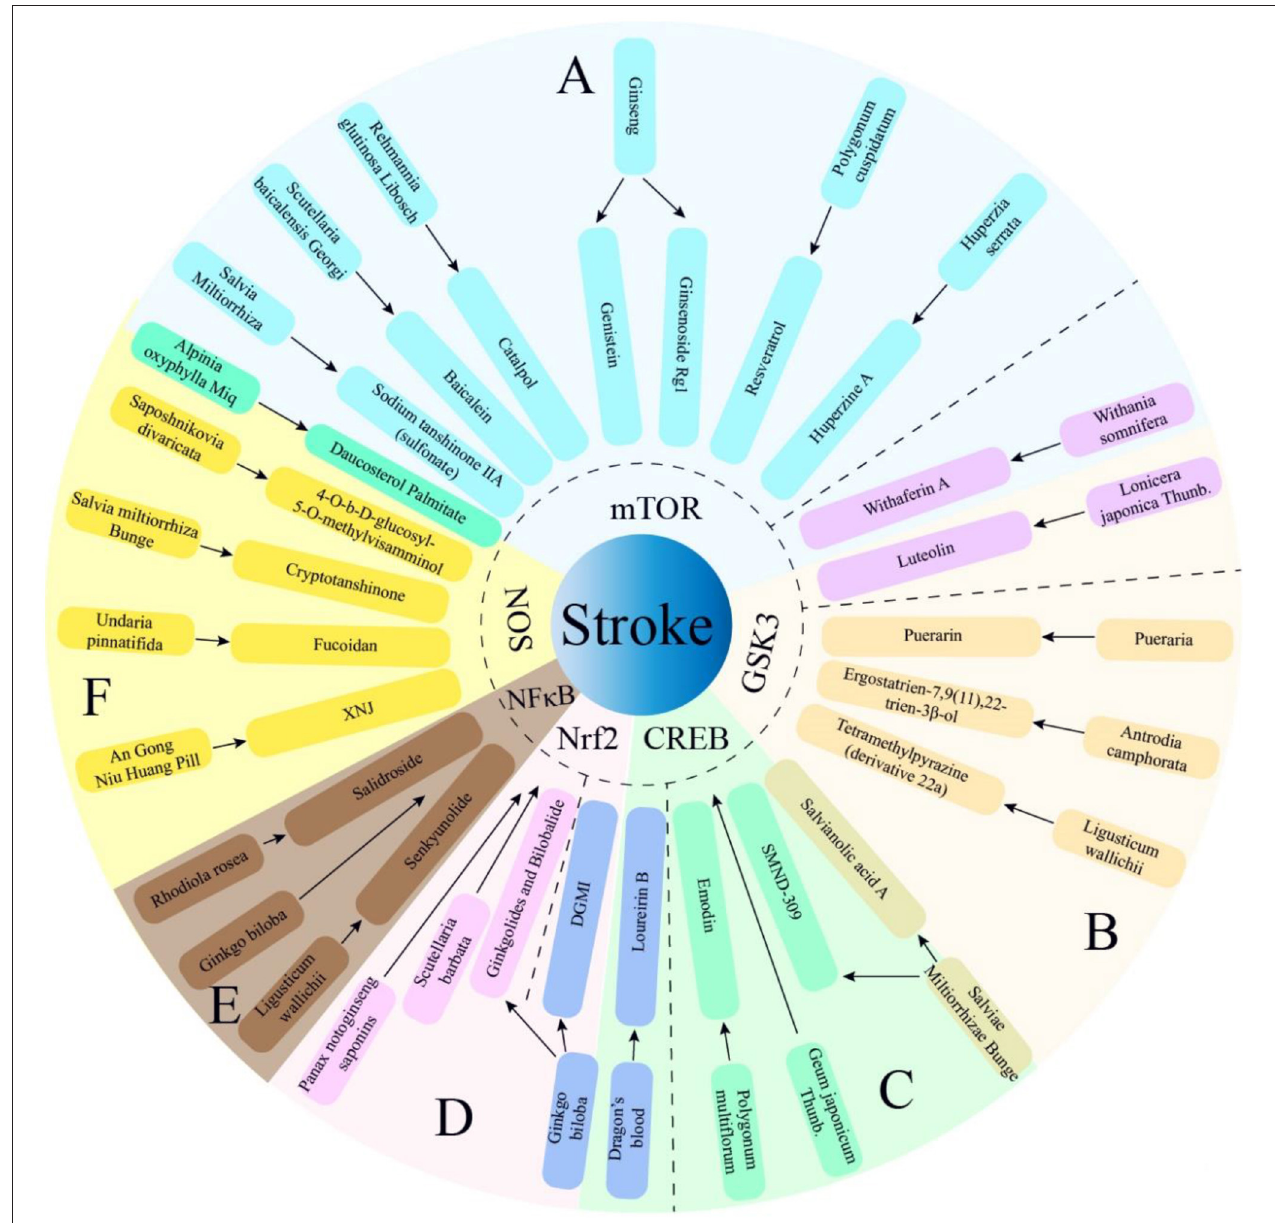
FIGURE 2 | Multiple active components from TCM herbs exert therapeutic effects via PI3K/AKT -mediated 6 main pathways. The TCM herbs of manuscript not mentioned above almost exert therapeutic effects via PI3K/AKT -mediated Bcl-2 pathway. SMND-309, a chemical derivant of propenoic acid of Sal A; DGMI, Diterpene ginkgolides meglumine injection; XNJ, Xingnaojing. (A) PI3K/AKT/mTOR; (B) PI3K/AKT/GSK3; (C) PI3K/AKT/CREB; (D) PI3K/AKT/Nrf2; (E) PI3K/AKT/NF- κ B; (F)